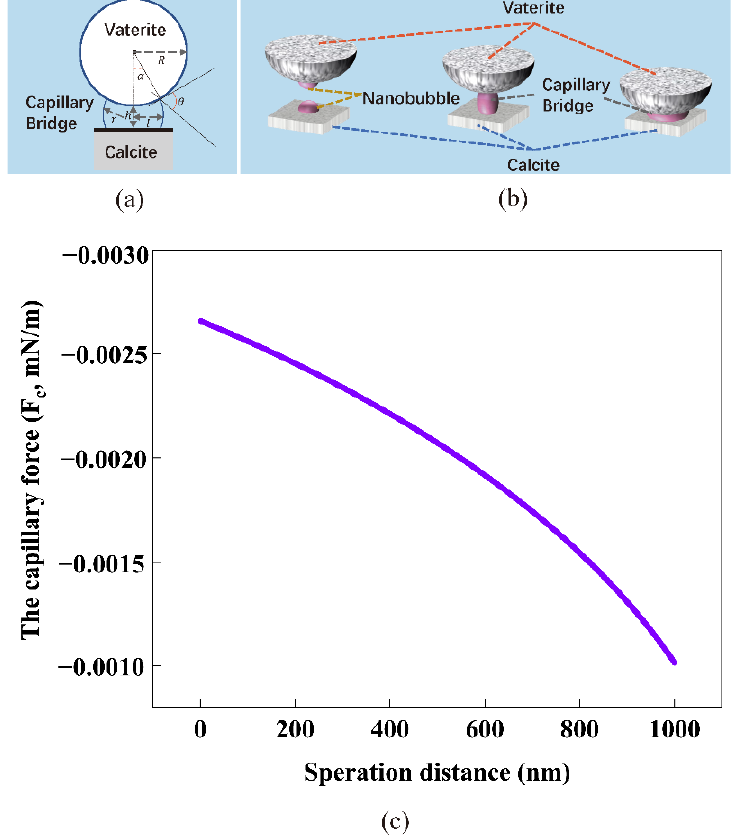
Figure 15. The geometry of vaterite and calcite particles used to calculate the capillary force between them ( a ); simplified mechanism of a nanobubble bridging the surfaces of vaterite and calcite particles ( b ); the nanobubble capillary force bridging vaterite and calcite particles as a function of their surface distance ( c ).